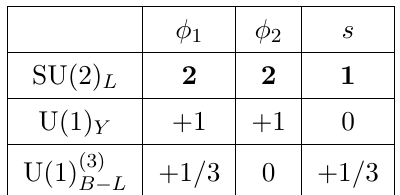
Table 1. Scalar (cid:12)elds and their charges under the Standard Model gauge group and the U(1) (3) gauge symmetry. In our notation, the U(1) (3) for the third family leptons is (cid:0) 1. The (cid:12)rst two families of fermions have zero U(1) (3)